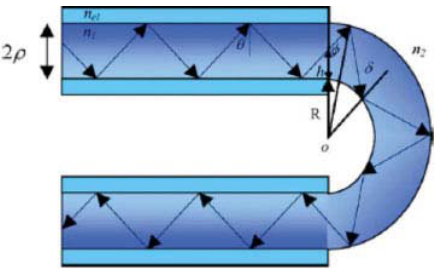
Figure 3. Schematic of an unclad U-bent multimode optical fiber [12]. reproduced by the permission ofJohn Wiley and